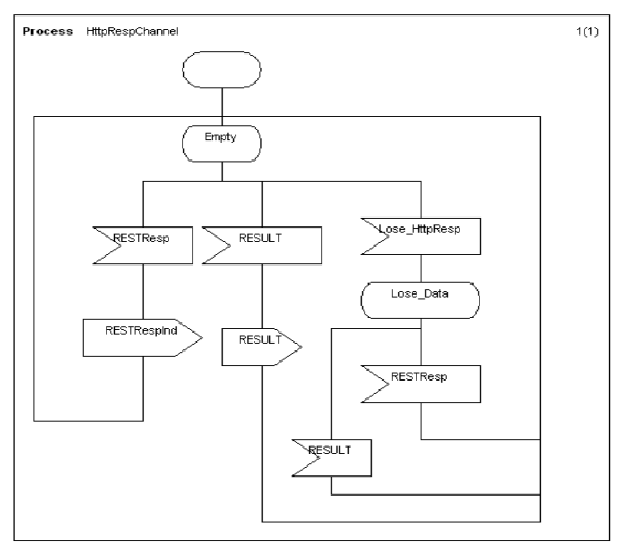
Figure 12:httpRespChannel